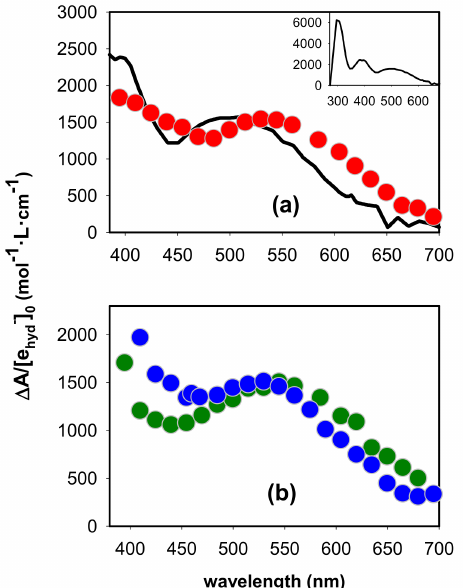
Figure 2. Experimental absorption spectra (circles) determined at 3 µ s by photoionization of ( a ) the symmetric structure (AG 4 A) 4 /K + (red) and ( b ) the two asymmetric analogues (G 4 A) 4 /K + (green) and (AG 4 ) 4 /K + (blue) at pH 3; ∆ A was divided by the initial concentration of hydrated ejected electrons. The black line in ( a ) corresponds to the absorption spectrum reported for the radical cation of dGMP [39], plotted with its molar absorption